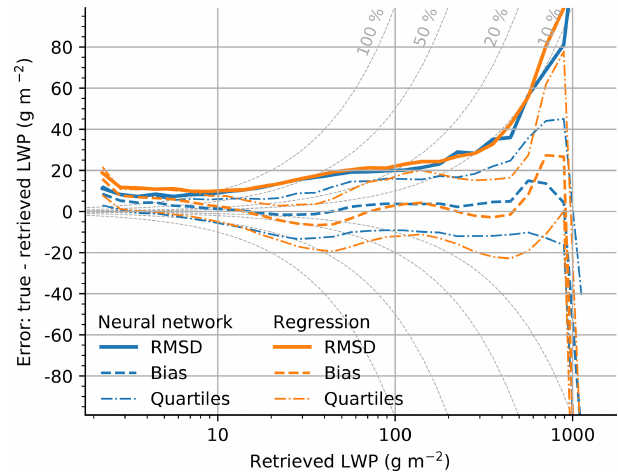
Figure 7. As Fig. 6 but with errors shown as a func- tion of retrieved LWP. Retrievals are trained and tested with 1gm − 2 < LWP < 1000gm − 2 . The first bin contains all data with retrieved LWP < 2.5gm − 2 (including